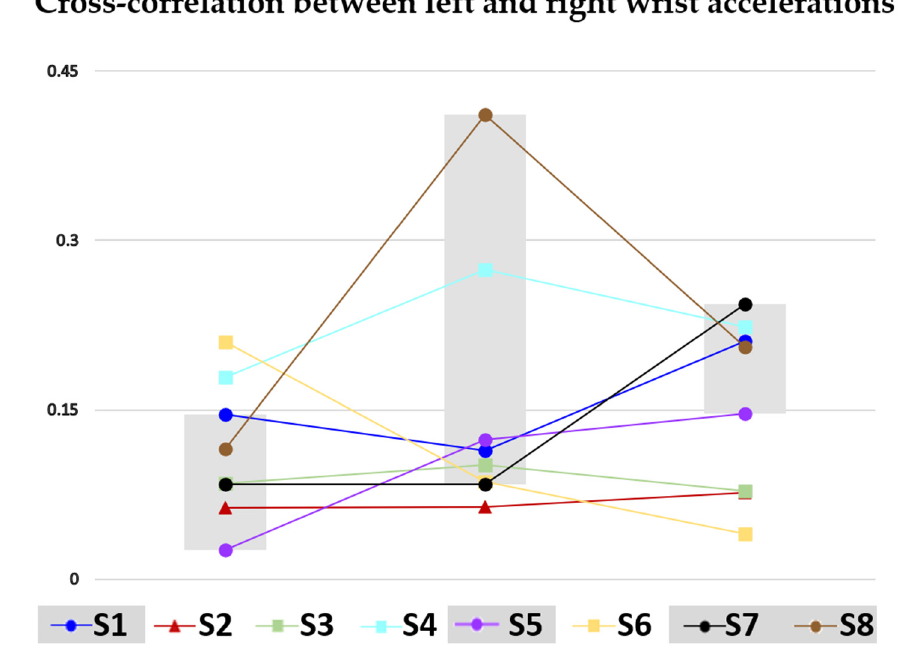
Figure 5. Cross-correlation between the left and right wrist acceleration for each infant at each timepoint (3, 4, and 5 months). Infants not suggesting atypical development to both physicians are identified with circles, infants raising the concern of both physicians are identified with triangles, and infants differently evaluated by the physicians are identified by squares. Infants not suggesting atypical development define the gray interval at each time point.